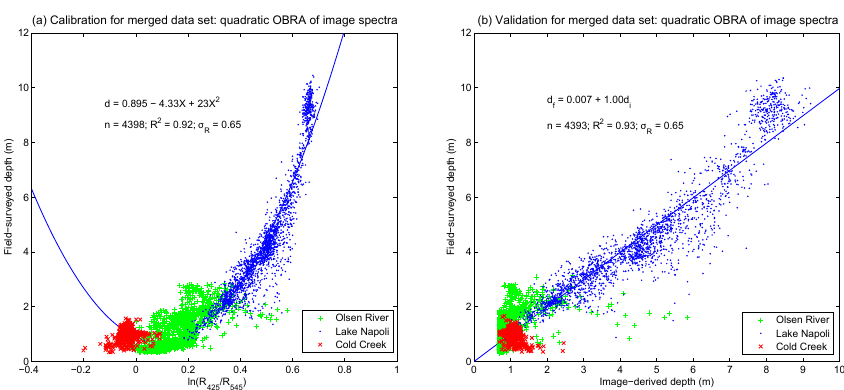
Fig. 5. (a) Calibration of the image-derived quantity X to water depth for the merged data set drawn from all three field sites, distinguished by the symbols shown in the legend. (b) Validation of image-derived depth estimates via regression of observed vs. predicted depths for a subset of the merged data set. Table 3. Accuracy assessment for depth retrieval from WV2 satellite images of supraglacial water bodies on the GrIS.